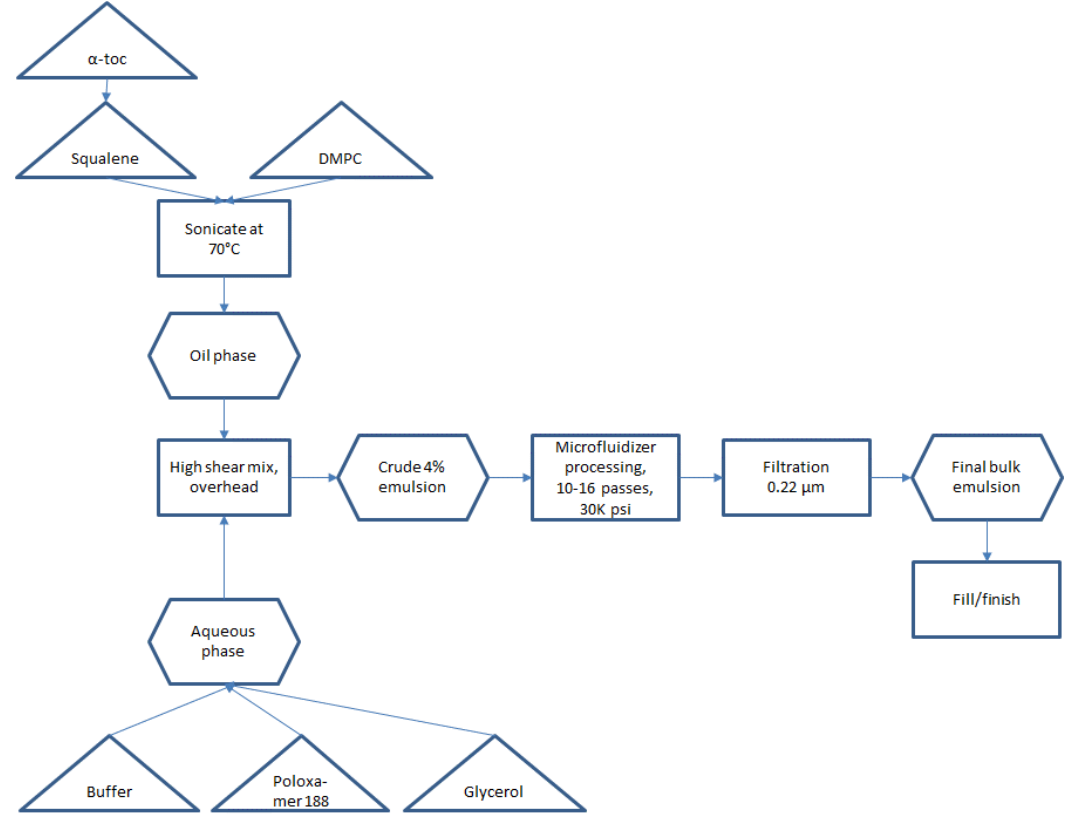
Figure 1. Small-scale ( ≤ 1 L) process flow diagram for production of SE.